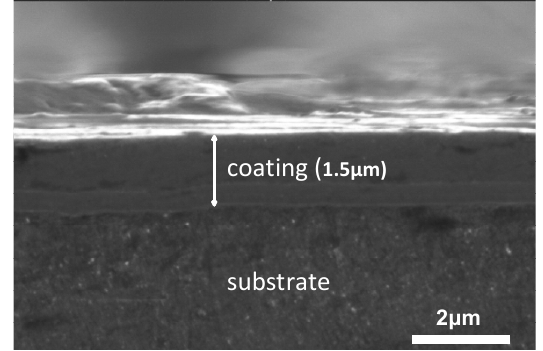
Figure 6. Cross-section topography of the TiCN coating.